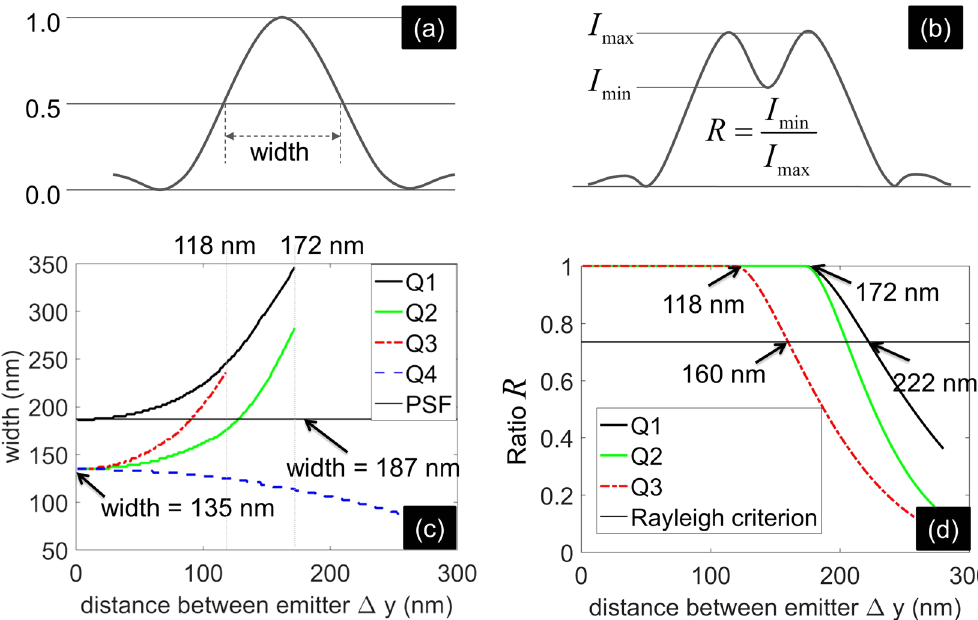
Figure 3. Properties of the matrices C {1,2,3} are illustrated through FWHM (definition in ( a ), result in ( c )) and minima to maxima ratio (defined in ( b ), result in ( d )) of Q1–Q4 as functions of Δ y